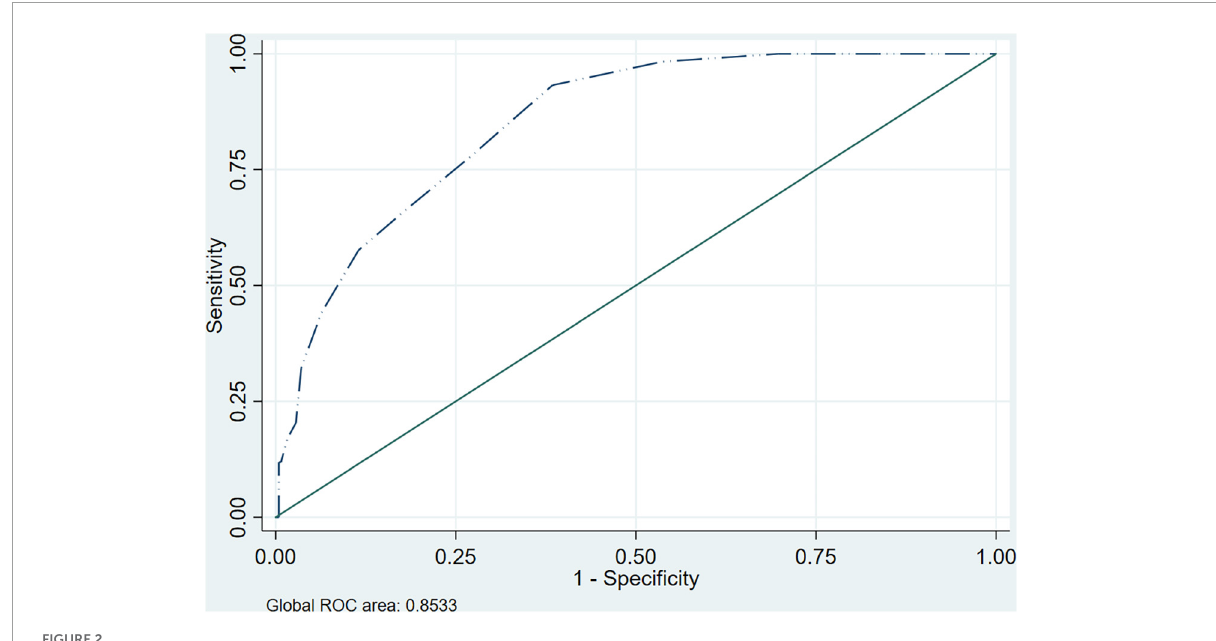
FIGURE2 ROC curve and AUC HSCL-5 vs.